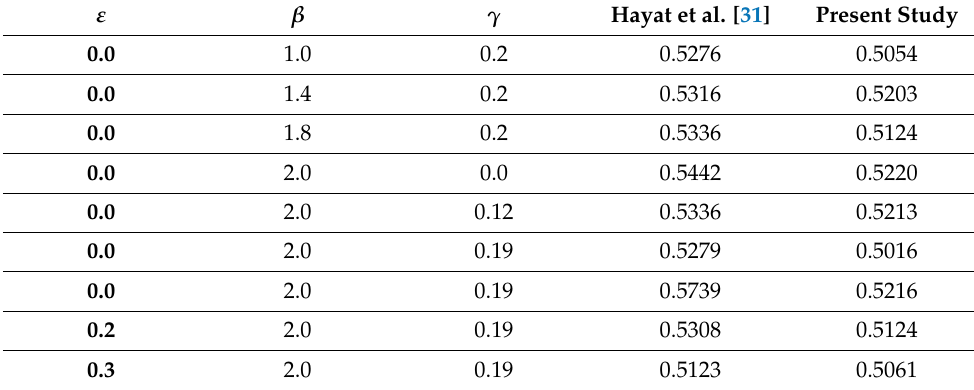
parameters based on various input parameters.